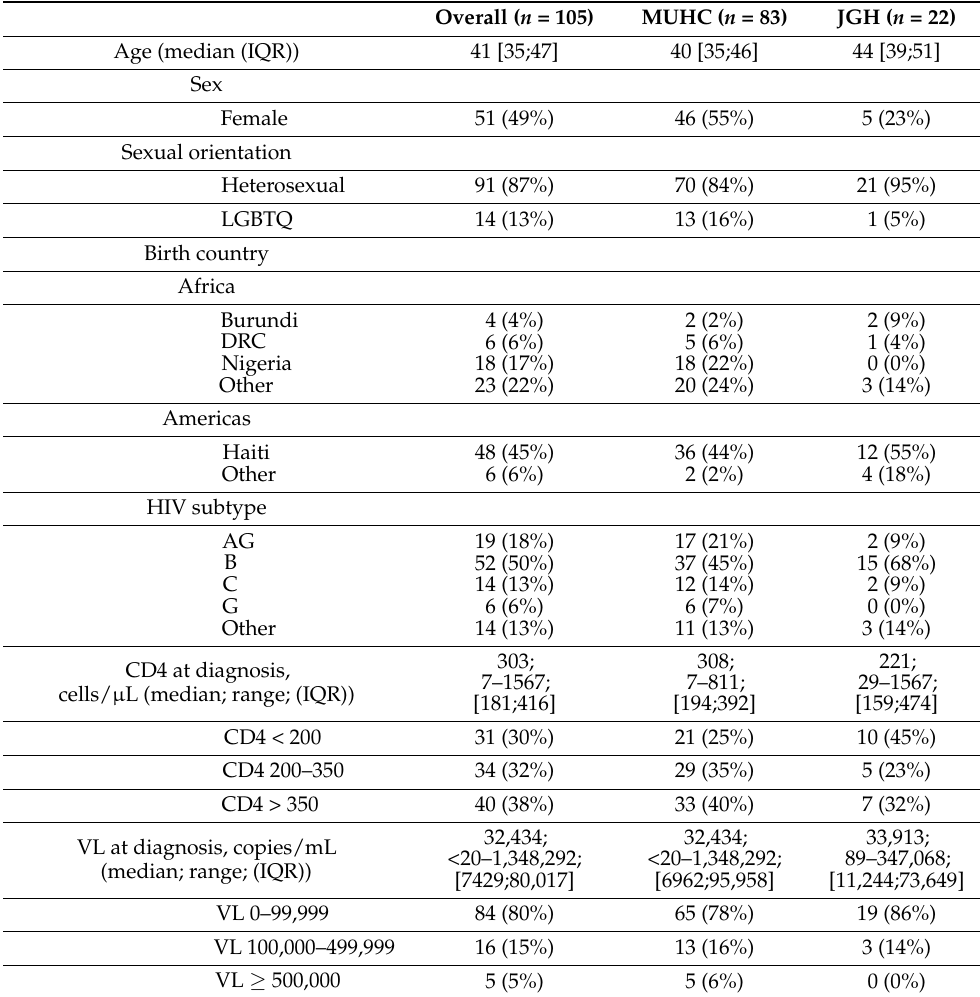
Table 1. Baseline characteristics of the study